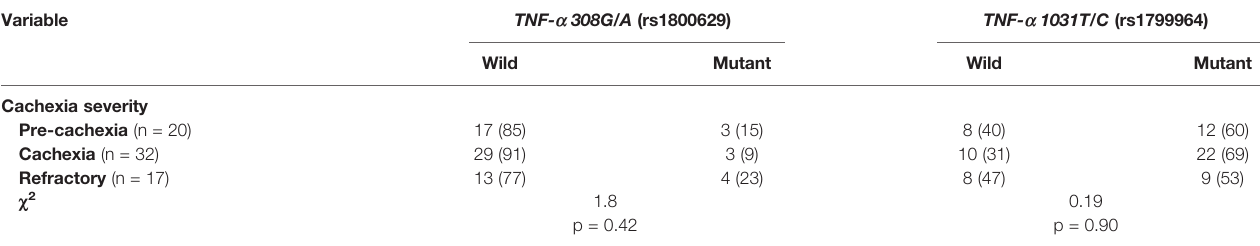
TABLE 2 | Distribution of TNF- a gene alleles among cachectic pancreatic cancer patients considering the cachexia severity. Variable